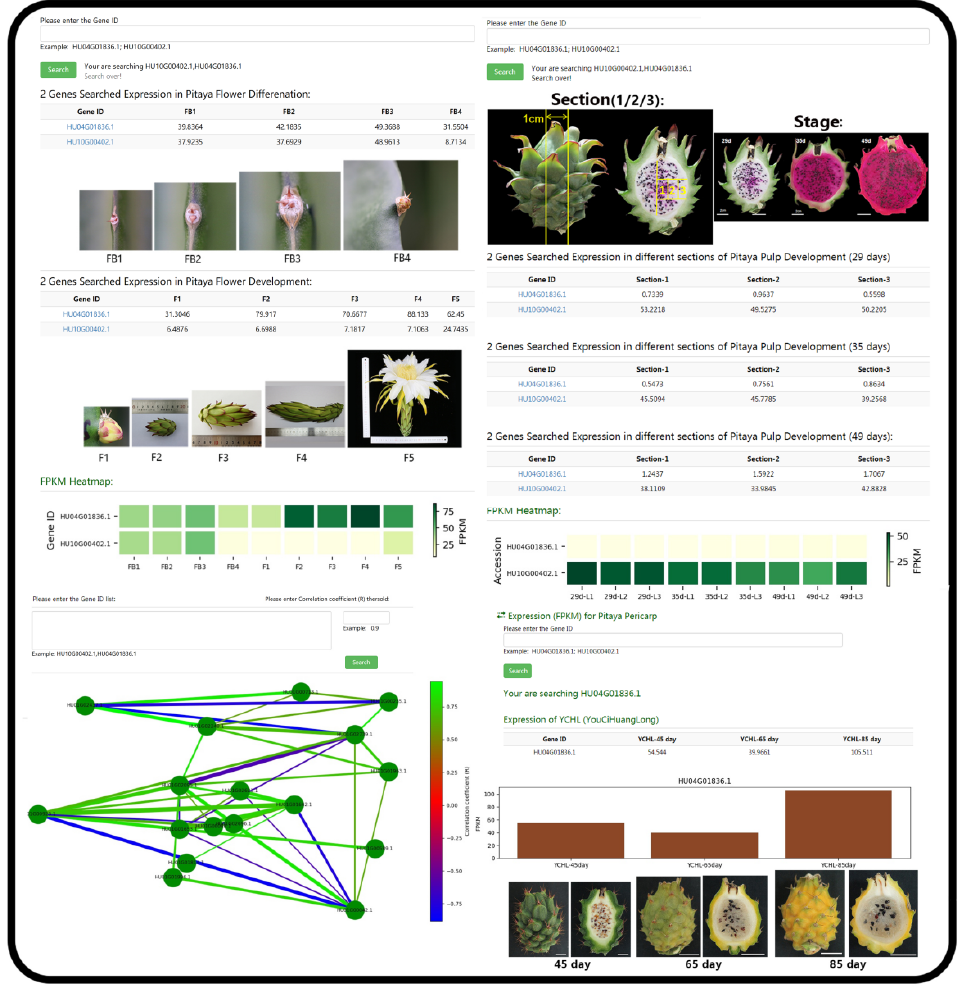
Figure 5. The screenshots of representative resources and action page example for the ‘Expression’ module. ‘Expression’ module displayed the gene expression data of each tissue in various development stages through the expression calorimetry, histogram and corresponding table forms. Users can input lists of gene symbols and gain the coexpression relationship and visual network diagram through the algorithm based on Pearson correlation coefficient in coexpression function of ‘Expression’ module.